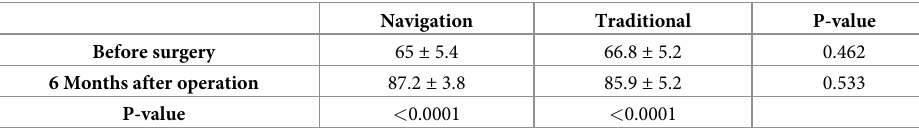
Table 3. American shoulder and elbow surgeons shoulder